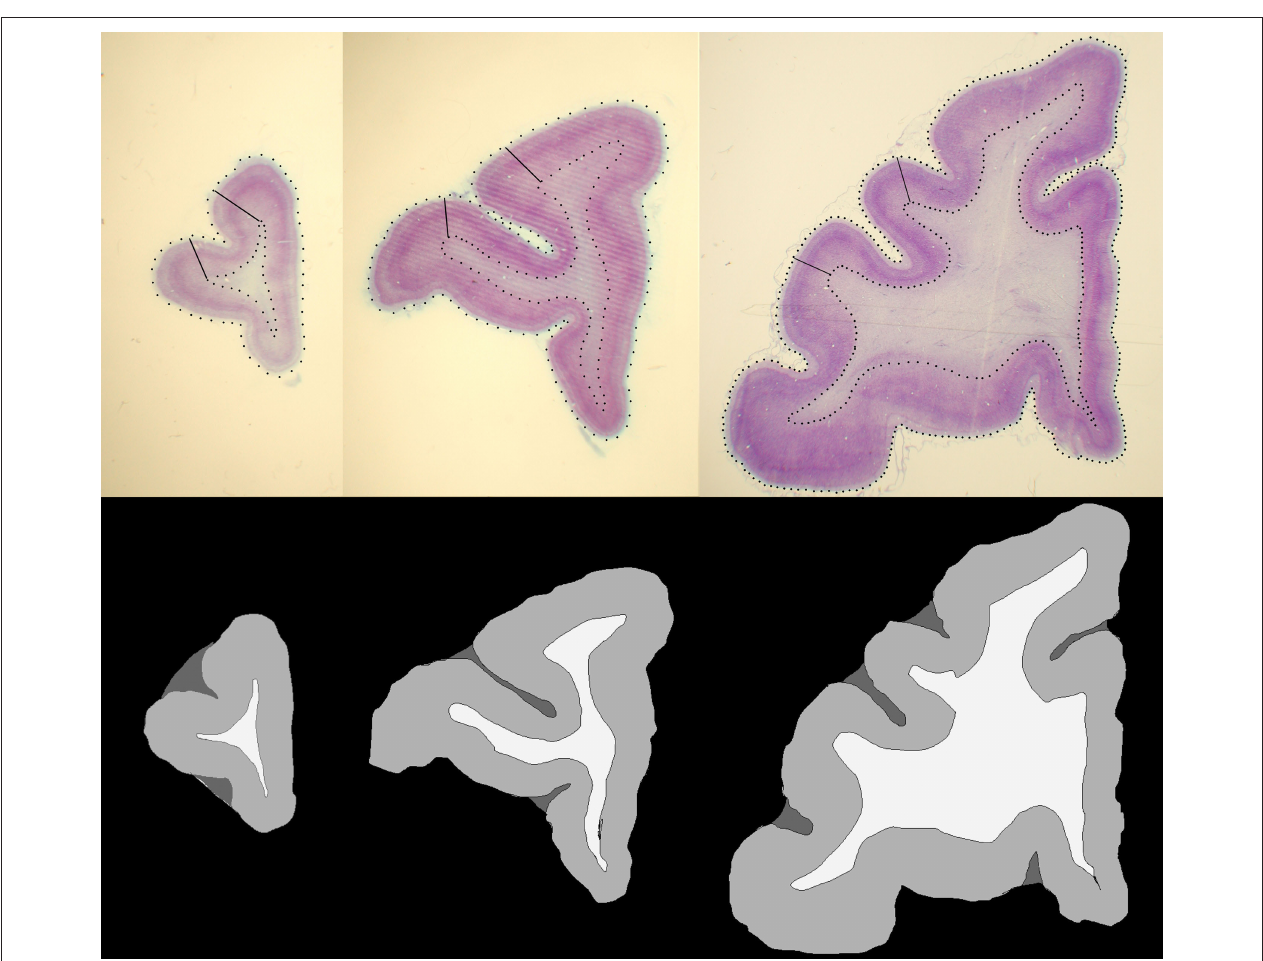
FIguRe 2 | examples of histological sections (top row) and corresponding gM, WM, CSF segmentations (bottom